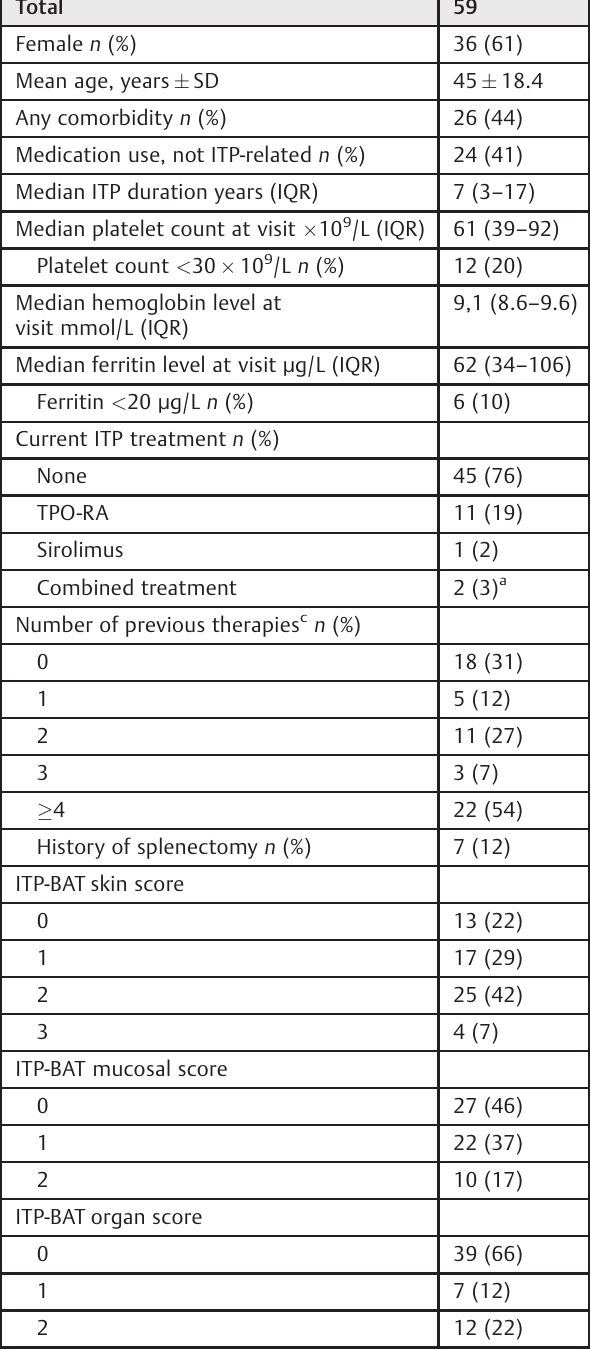
Table 1 Baseline